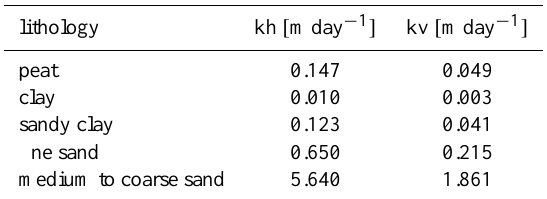
Figure 8 Lithologies in the 3D voxel model of the Holocene sequence; one out of the 50 equi- Fig. 8. Lithologies in the 3-D voxel model of the Holocene sequence; one out of the 50 equi-probable realizations, as calculated with the probable realizations, as calculated with the stochastic simulation technique, is shown. stochastic simulation technique, is shown. Table 1. Horizontal and vertical hydraulic conductivity (kh and kv) for the Holocene